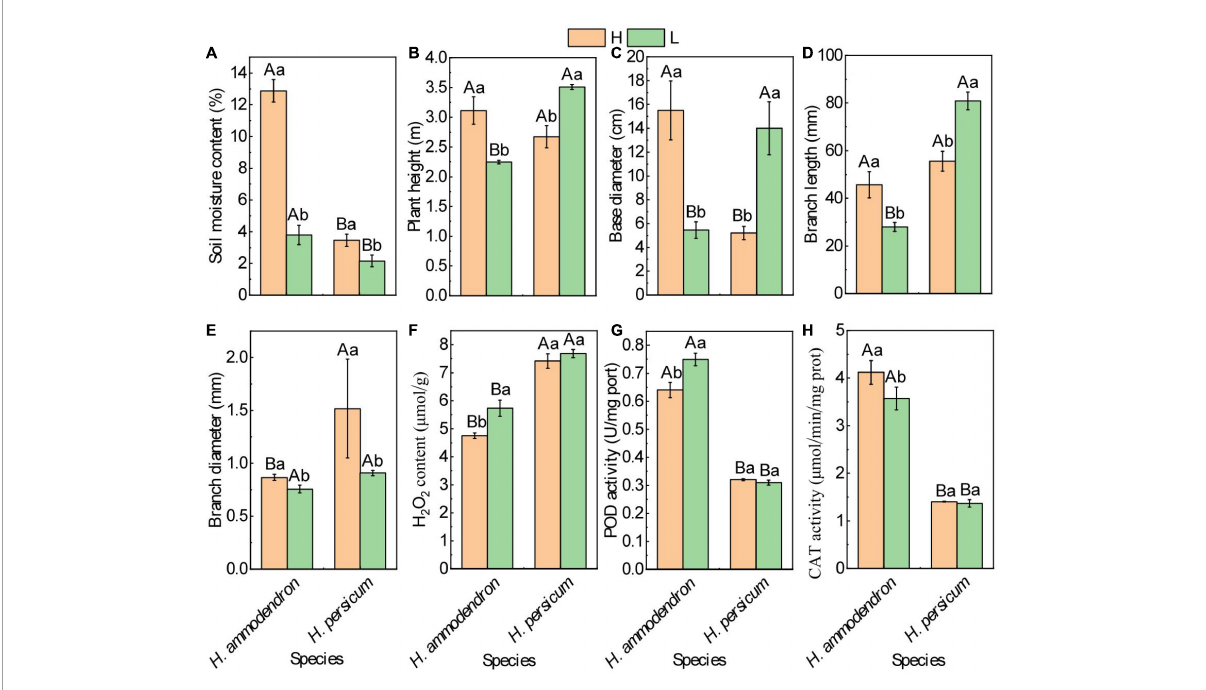
FIGURE2 Effects of drought stress on phenotypic and biochemical parameters of H. ammodendron and H. persicum . (A) Soil moisture content; (B) plant height; (C) base diameter; (D) branch length; (E) branch diameter; (F) H 2 O 2 content; (G) activities of POD; and (H) activities of CAT. H represents humid and low